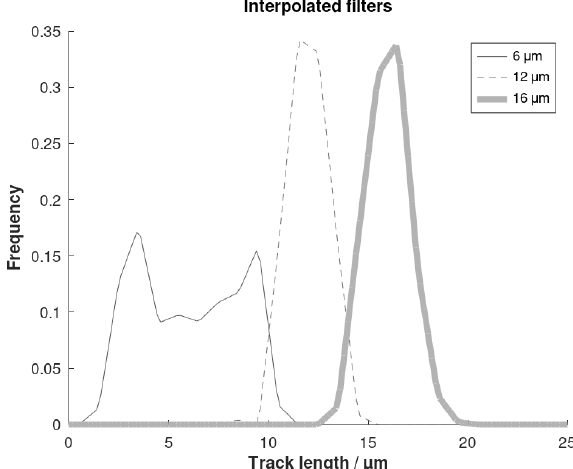
Figure B2. Three interpolated filters with mean track lengths of 6, 12, and 15µm extracted from Fig.